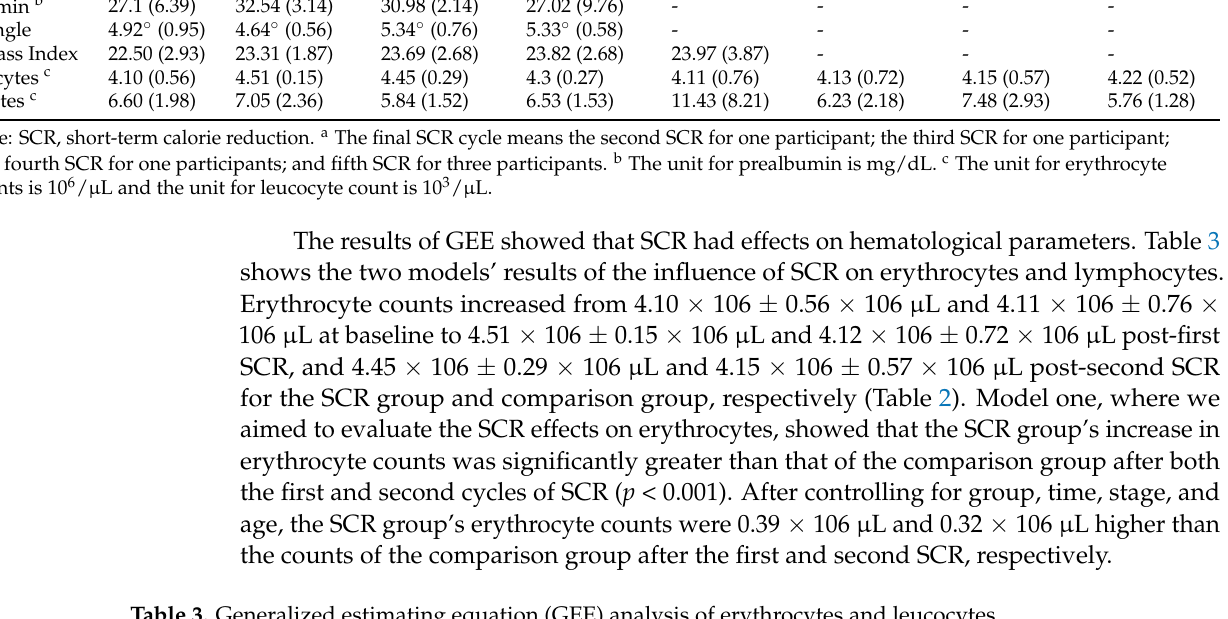
Table 3. Generalized estimating equation (GEE) analysis of erythrocytes and